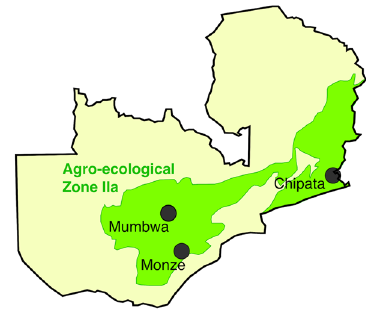
Figure 8. Map of Zambia showing Agro ‐ ecological Zone IIa and approximate locations of Mumbwa, Monze, and Chipata study areas